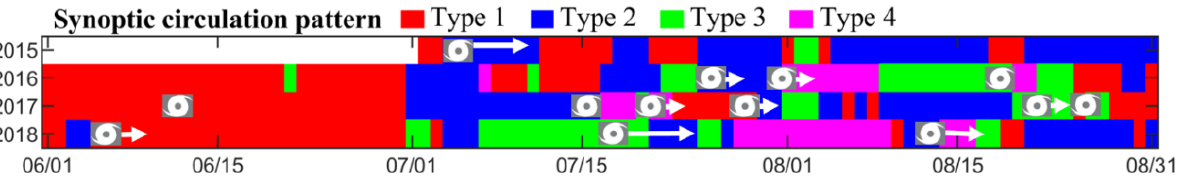
Figure 11. Sequence of daily changes under the four synoptic patterns and typhoon passage period (the typhoon mark indicates the start time of the typhoon, and the arrow head indicates the end).